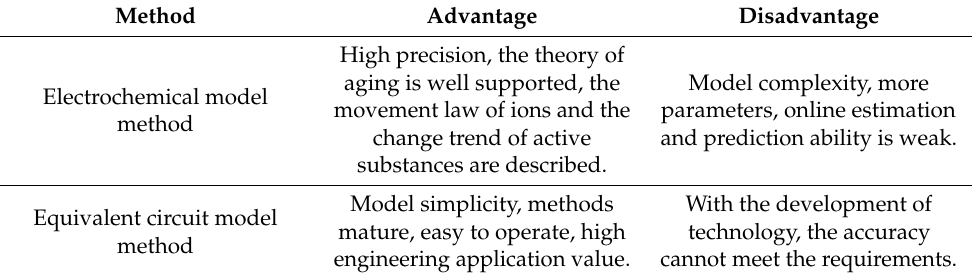
Table 2. Advantage and disadvantages of lithium-ion battery models. Method Advantage Disadvantage